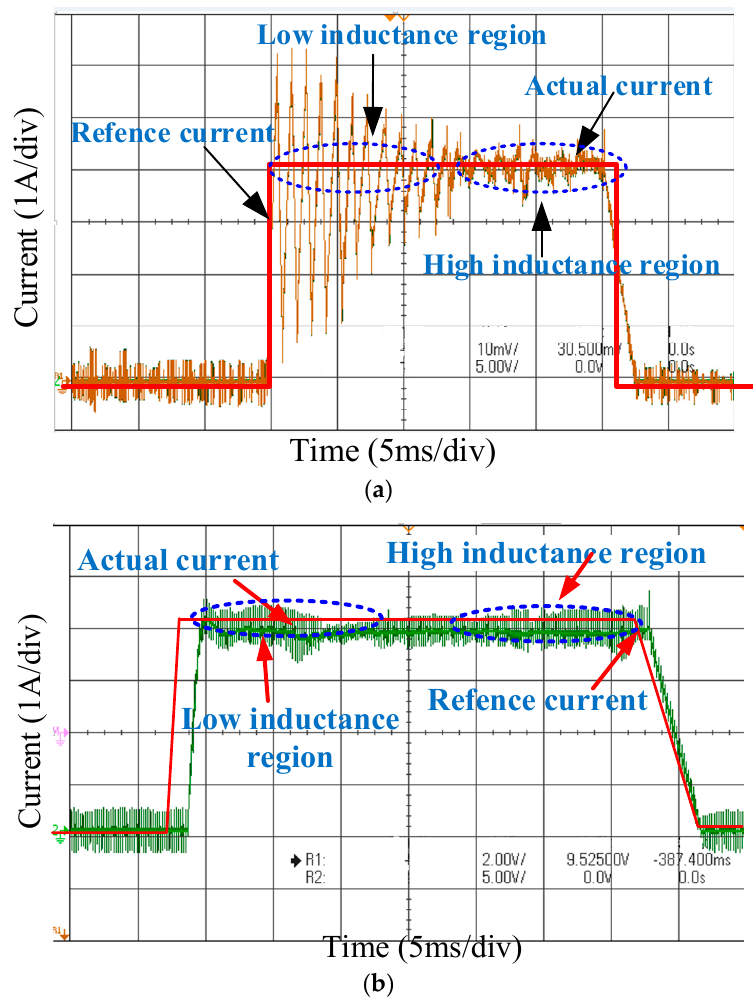
Figure 14. Experimental results. ( a ) Conventional current hysteresis control (the hysteresis band is 0.1 A, the reference is 4 A, and the switching frequency is 10 KHz) and ( b ) the proposed current control switching method (Frequency = 10 KHz).